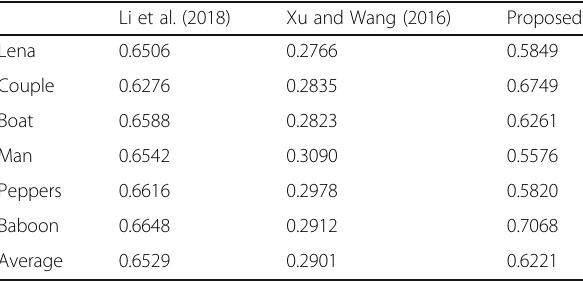
Table 2 Operation time comparisons among Xu and Wang ’